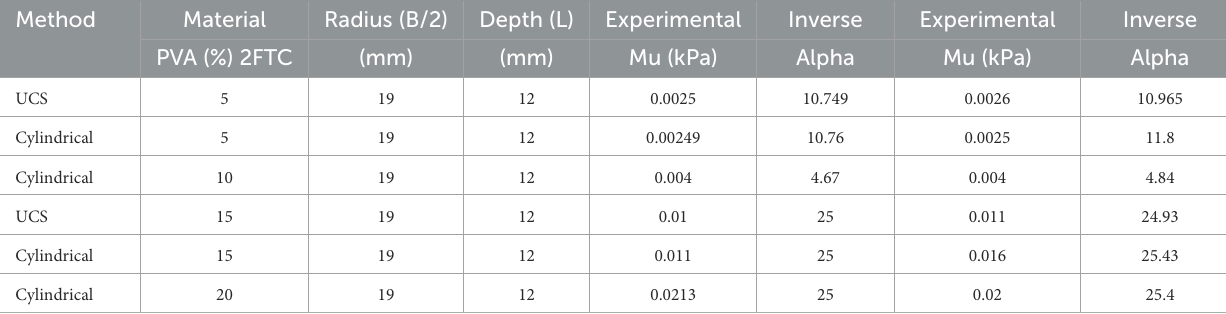
TABLE 2 For cylindrical and uniaxial indentation ( µ , α ) obtained from the inverse analysis.